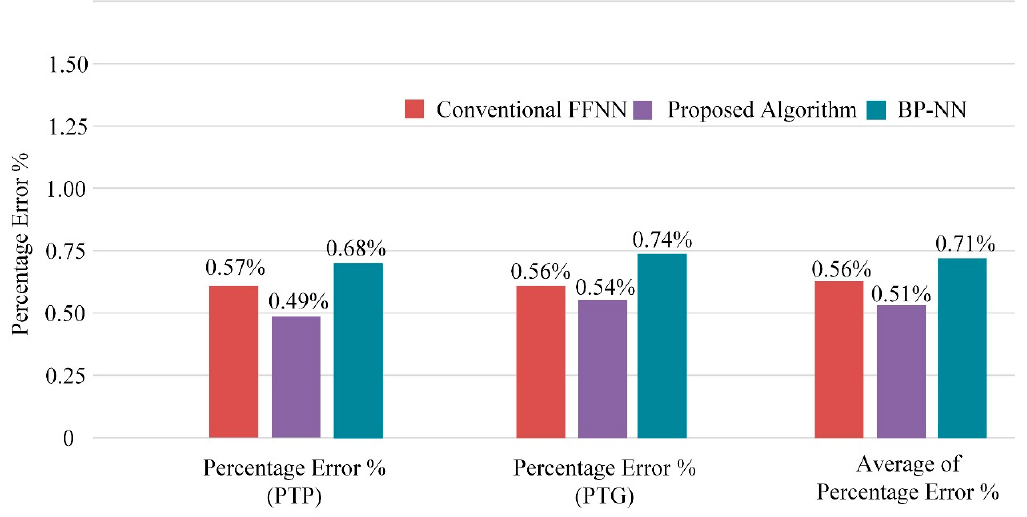
Figure 13. Comparative analysis.